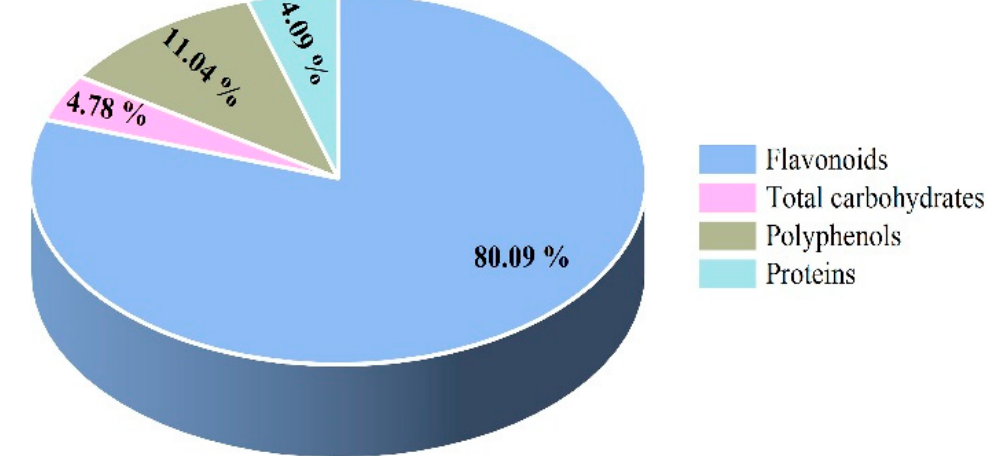
Figure 1. The category and percentage of main components in the extract of flavonoids from the fruits of Lycium barbarum .